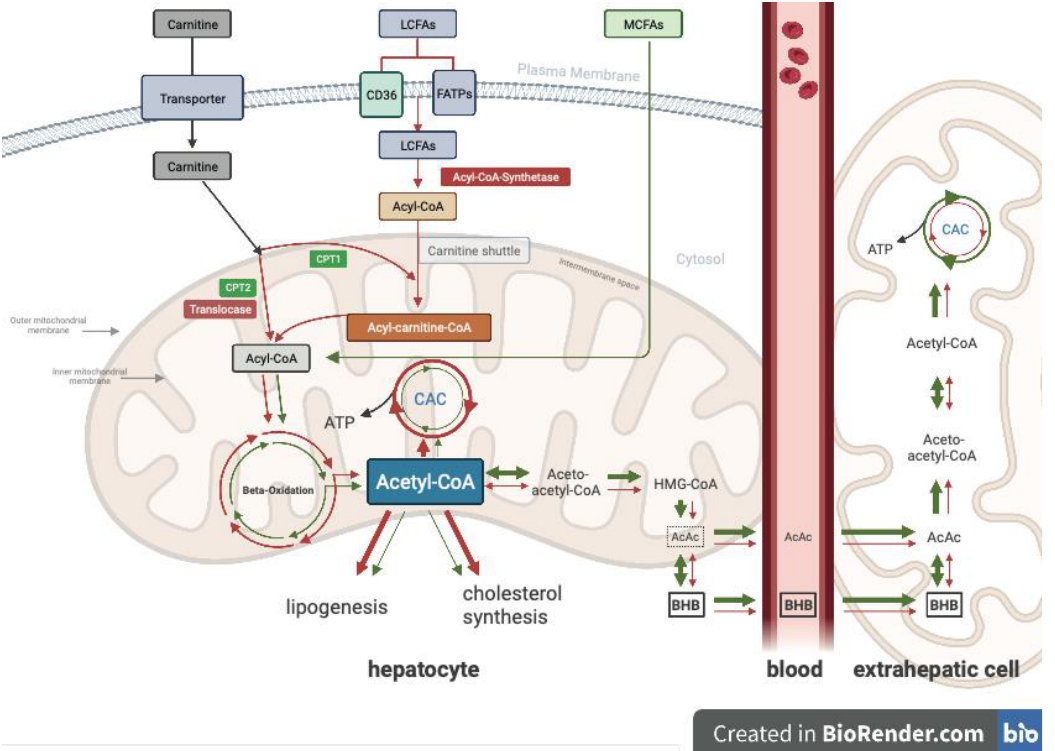
Figure 1. Simplified illustration of medium-chain fatty acid metabolism (represented by the green